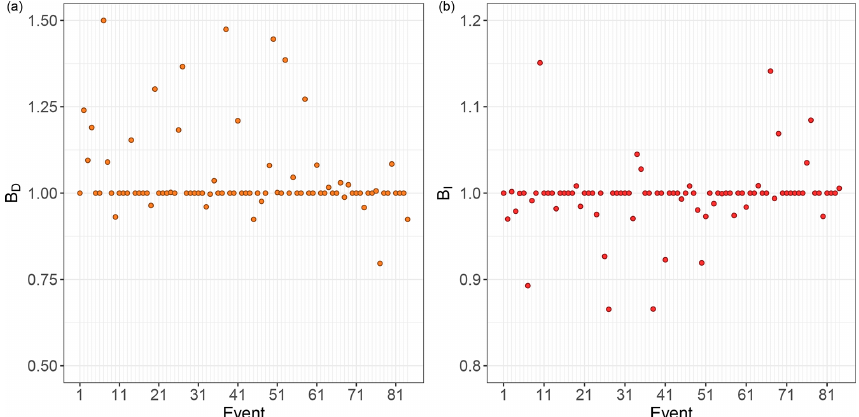
Figure 12. Bias of (a) duration B D and (b) intensity B I between the mean values of the D and I distributions obtained performing the first MC simulation and the corresponding reference values for each